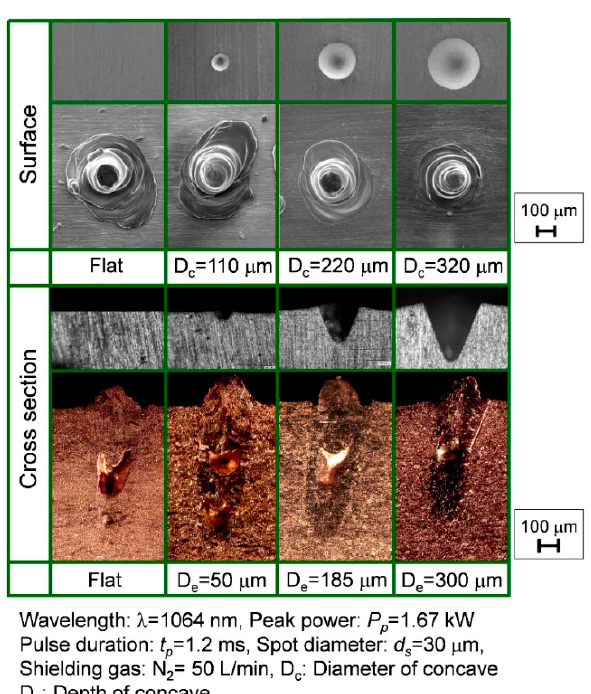
Figure 7. Surface and cross-section appearances for flat surface and various concave holes before and after keyhole welding, with irradiation at bottom center of